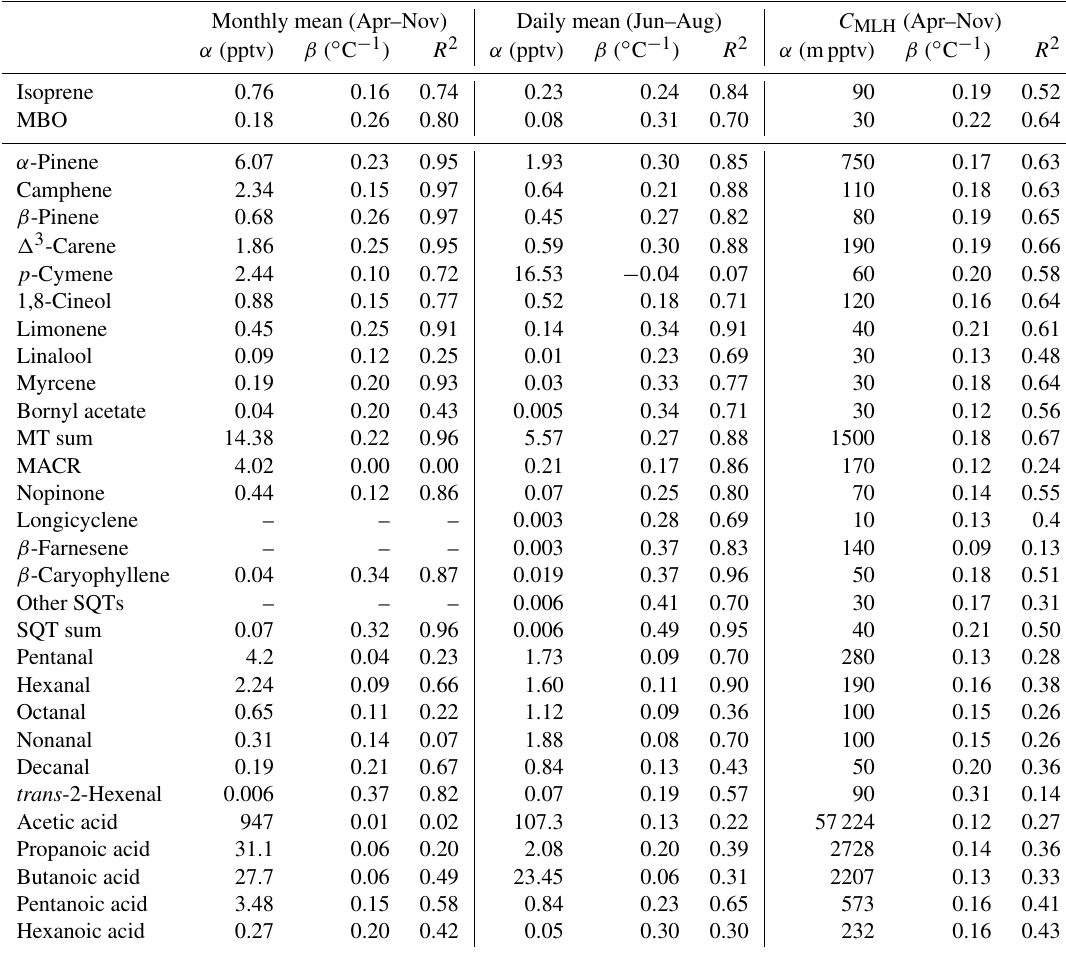
Table 3. Correlation of VOC concentrations with temperature at SMEAR II in 2016, intercept ( α ) of temperature dependence curve, tem- perature sensitivity ( β ), and temperature correlations ( R 2 ) of monthly (April–November) and daily (June–August) mean concentrations and mixing layer height (MLH)-scaled concentration of individual measurement points ( C MLH ). The fitted curves were exponent functions y = αe βx , where y is the concentration or MLH-scaled concentration, x is the temperature and β is the temperature